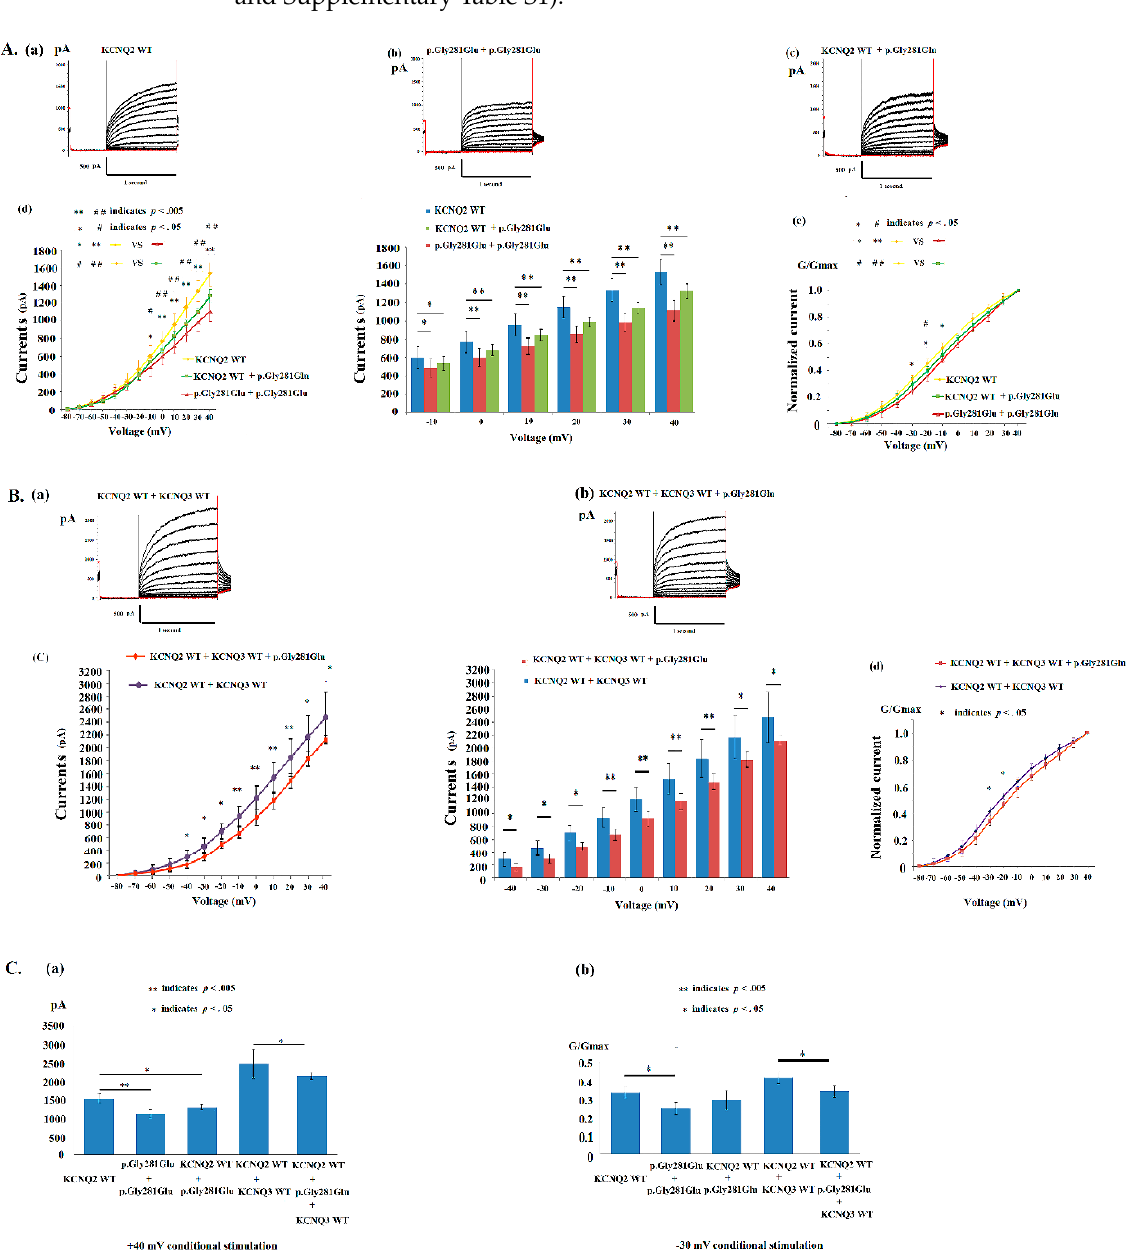
Figure 3. ( A ) The cells transfected with the ( a ) KCNQ2 wild type (WT) (2 μ g) ( n = 22), ( b ) homomeric p.Gly281Glu (2 μ g) ( n = 8) and ( c ) heteromeric p.Gly281Glu + KCNQ2 WT (1 μ g:1 μ g) ( n = 8) were analyzed. The voltage-clamp steps were from − 80 mV and +40 mV in 10-mV increments. ( d ) Cells transfected with p.Gly281Glu exhibited lower [ p < 0.05 ( p values see Supplementary Table S1); − 10 + 40 mV) currents in homomeric p.Gly281Glu and in heteromeric p.Gly281Glu + KCNQ2 WT [ p < 0.05 ( p values see Supplementary Table S1); − 10 + 40 mV] compared with KCNQ2 WT, correspondingly. * homomeric p. Gly281Glu versus KCNQ2 WT; # p. Gly281Glu + KCNQ2 WT versus KCNQ2 WT. ( e ) The normalized currents in homomeric p. Gly281Glu were lower (G/G max) ( p < 0.05; − 30 to − 10 mV) than those in cells with KCNQ2 WT. ( B ) The ( a ) KCNQ2 WT + KCNQ3 WT (1 μ g:1 μ g) ( n = 10) and ( b ) KCNQ2 WT + p. Gly281Glu + KCNQ3 WT (0.5 μ g:0.5 μ g:1 μ g) ( n = 8) were analyzed. ( c ) The KCNQ2 WT + p.Gly281Glu + KCNQ3 WT exhibited lower currents [ p < 0.05 ( p values see Supplementary Table S1)] compared with KCNQ2 WT + KCNQ3 WT from − 40 to +40 mV conditional stimulation. ( d ) The normalized currents in p.Gly281Glu + KCNQ2 WT + KCNQ3 WT were lower (G/G max) than those in cells with KCNQ2 WT + KCNQ3 WT at − 30 [t(16) = 2.81, p = 0.012] and − 20 mV [t(16) = 2.72, p = 0.018] stimulation. ( C ) ( a ) At +40 mV stimulation, the currents in KCNQ2 WT and KCNQ2 WT + KCNQ3 WT are superior to homomeric p. Gly281Glu (t(30) = 8.76, p < 0.001), heteromeric p. Gly281Glu + KCNQ2 WT ((t(30) = 4.18, p < 0.001), and KCNQ2 WT + p.